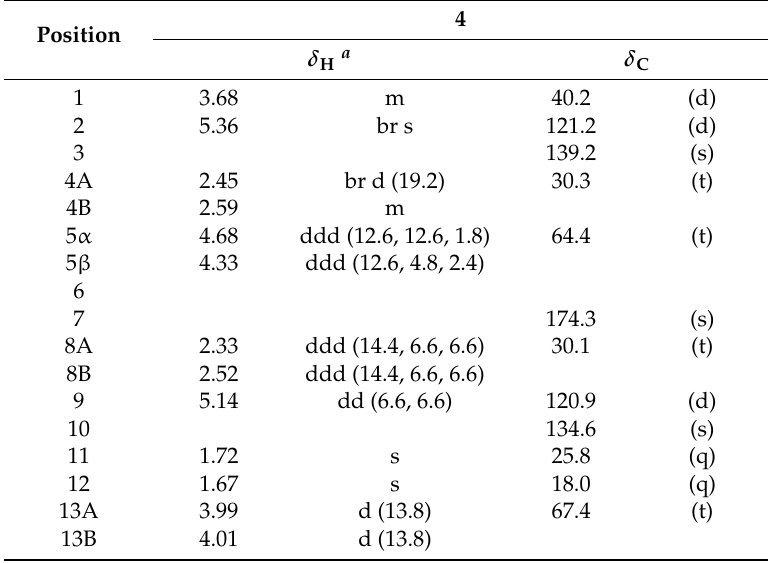
Table 2. 1 H and 13 C NMR spectral data for metabolites 4 in CDCl 3.